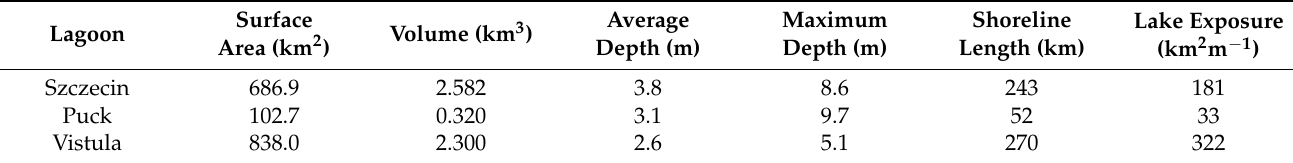
Table 1. Morphometric and bathymetric data for the coastal lagoons of the southern Baltic Sea after: [22,23,26].